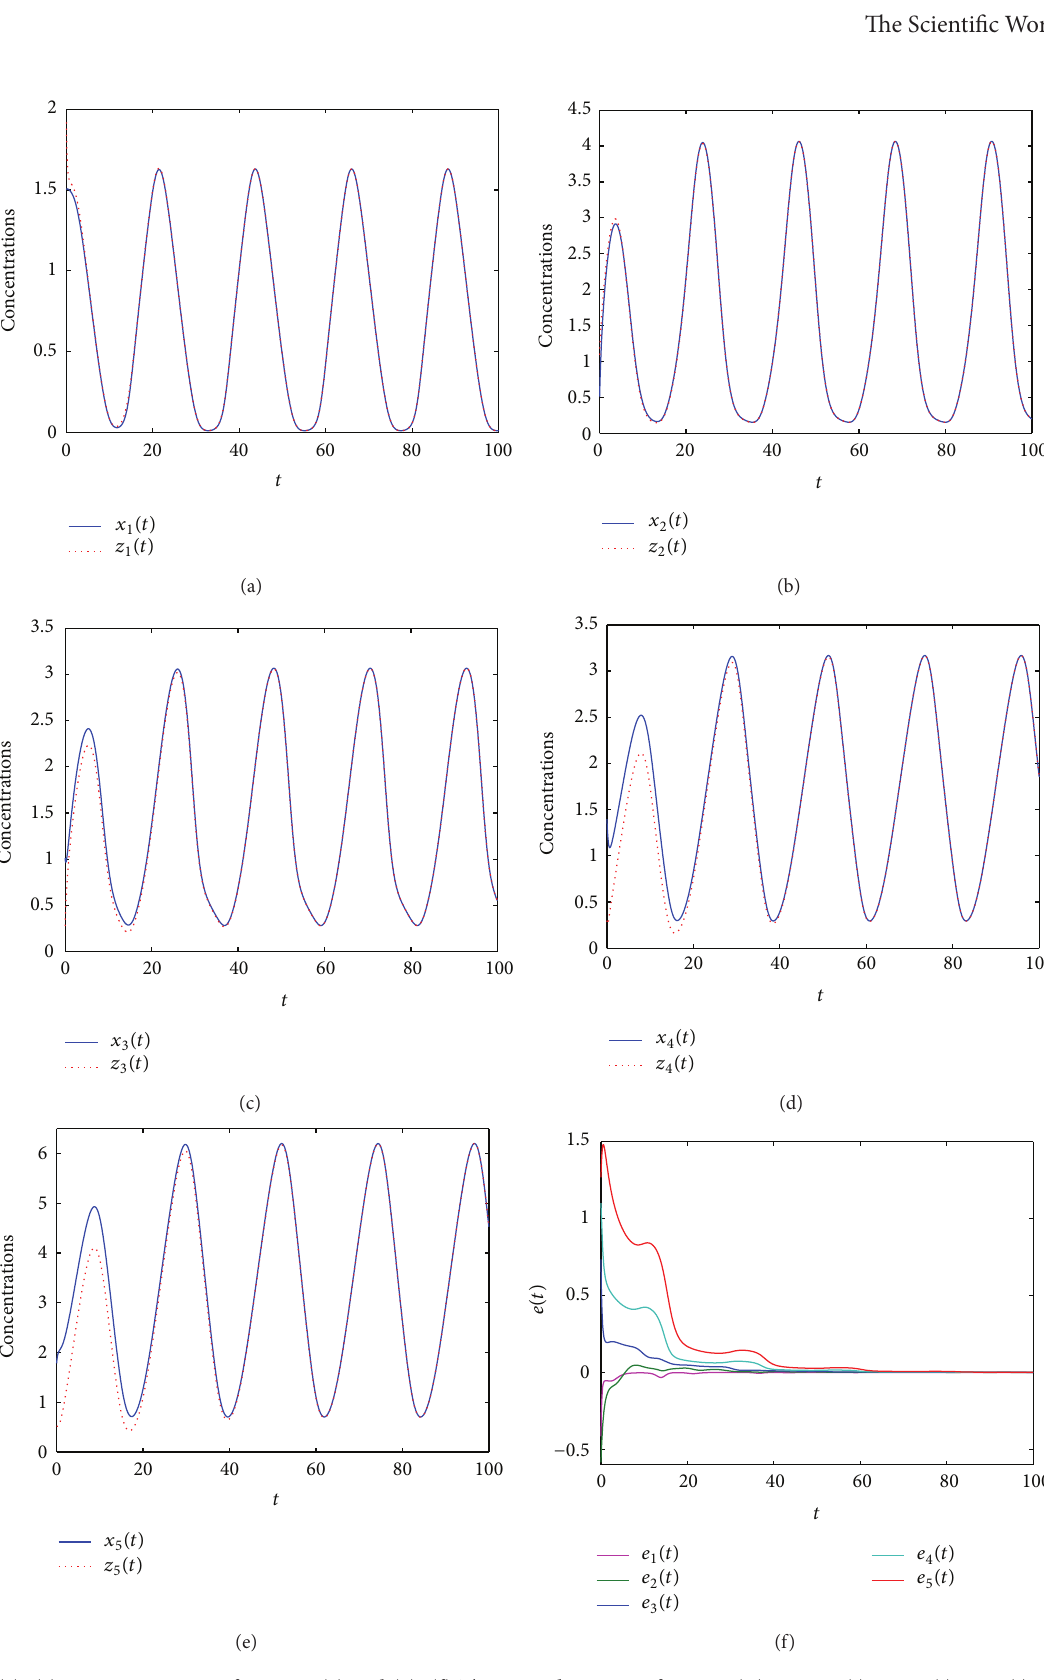
Figure 2: (a)–(e) State trajectories of systems (3) and (8). (f) The error dynamics of system (11). Here, 𝑢(𝑡) = 0, 𝑦(𝑡) = 𝑥 1 (𝑡), and 𝑘 = 5 . Initial values are randomly